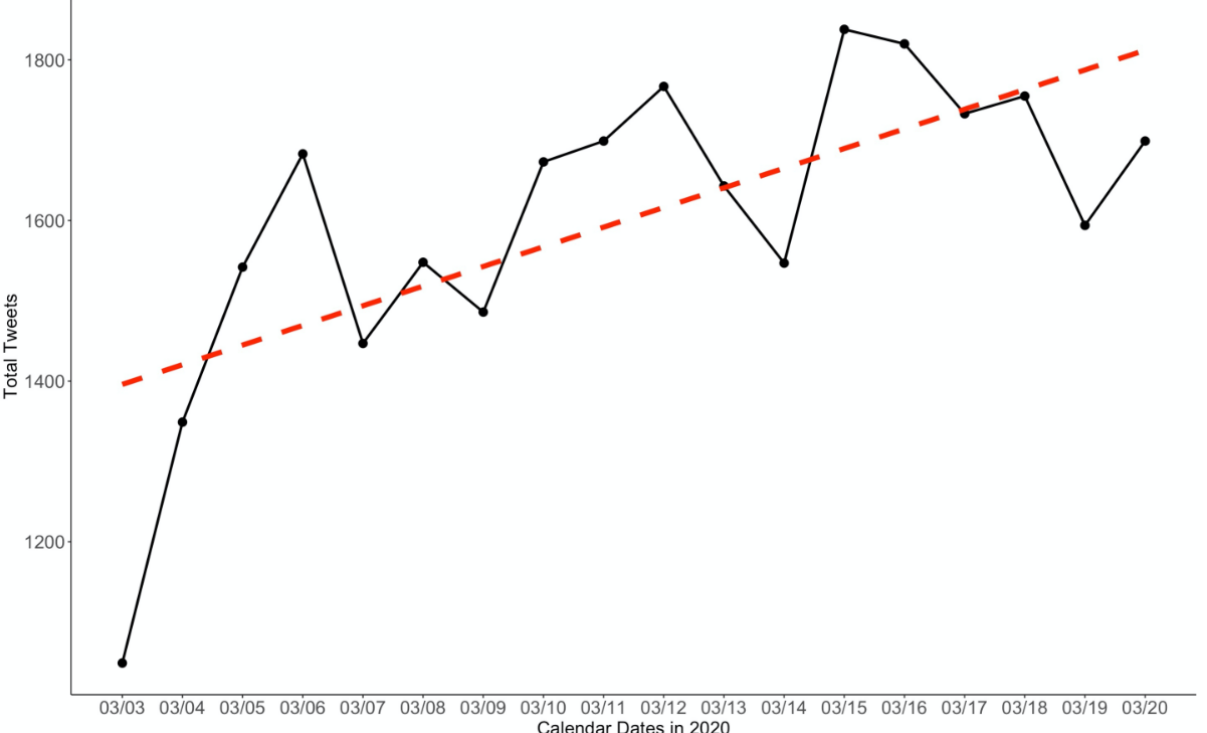
Figure 1. Volume of total signal Twitter posts filtered for the coronavirus disease symptom terms plotted over the study period (March 3-20,